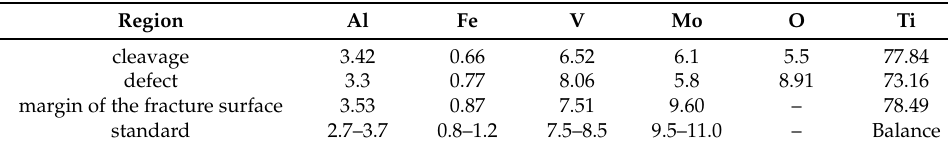
Table 1. Chemical constituents of the #1 screw (wt %).